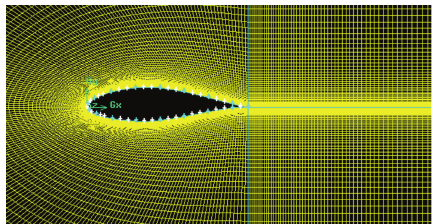
Figure 2: Mesh generated around the